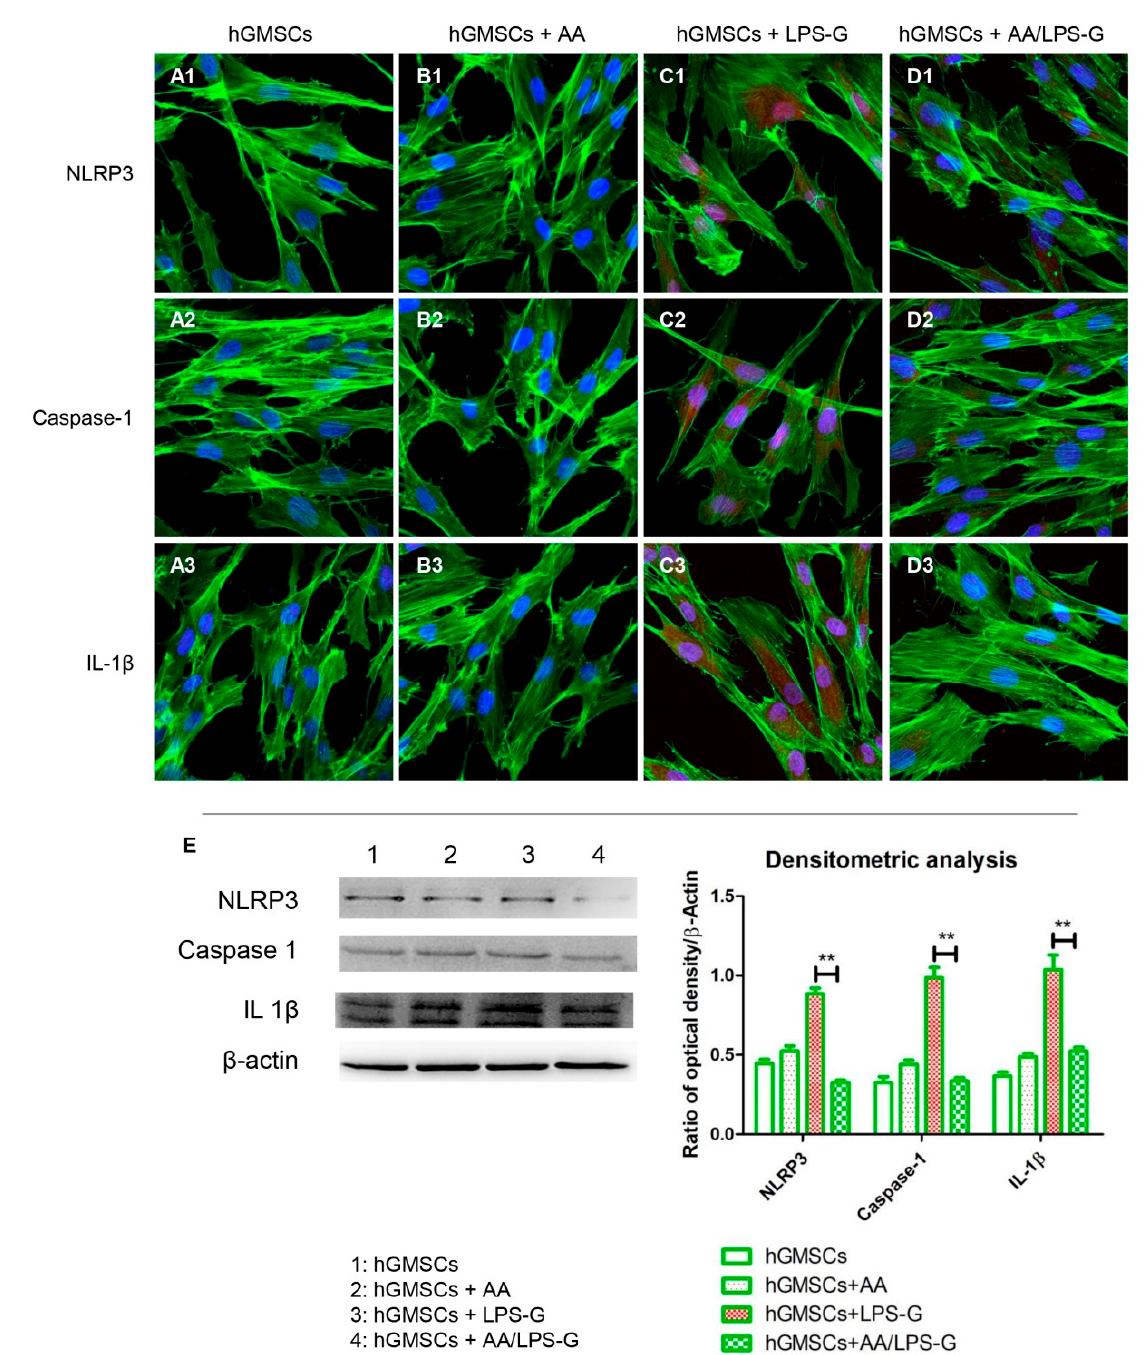
Figure 5. NLRP3/Caspase-1/IL-1 β signaling pathway and differences in protein levels in hGMSCs. Expression of NLRP3, Caspase-1 and IL-1 β , examined by confocal microscopy and Western blot experiments. ( A1 – D1 ) NLRP3 expression in hGMSCs (CTRL), hGMSCs + AA, hGMSCs + LPS-G, hGMSCs + AA/LPS-G. ( A2 – D2 ) Caspase-1 expression in hGMSCs (CTRL), hGMSCs + AA, hGMSCs + LPS-G, hGMSCs + AA/LPS-G. ( A3 – D3 ) IL-1 β expression in hGMSCs (CTRL), hGMSCs + AA, hGMSCs + LPS-G, hGMSCs + AA/LPS-G. ( E ) NLRP3, Caspase -1 and IL-1 β protein levels. β -actin was used as a loading control. Green fluorescence: cytoskeleton actin. Red fluorescence: NLRP3, Caspase-1, IL-1 β . Blue fluorescence: cell nuclei. Scale bar: 20 µ m. ** p <